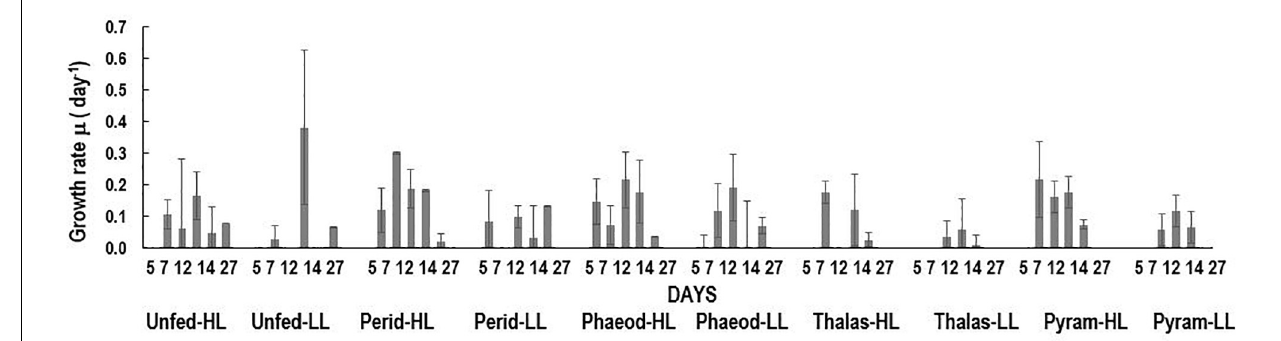
FIGURE 3 | Growth rates (day − 1 ) over the course of the experiment for unfed Noctiluca and for Noctiluca fed P. foliaceum (Perid), P. tricornutum (Phaeod), T. weissflogii (Thalas), and Pyramimonas sp. (Pyram) and exposed to optimal (250 µ E m − 2 s − 1 , HL) and low light (10 µ E m − 2 s − 1 , LL). Data points represent means ± SE ( n = 2) (day − 1